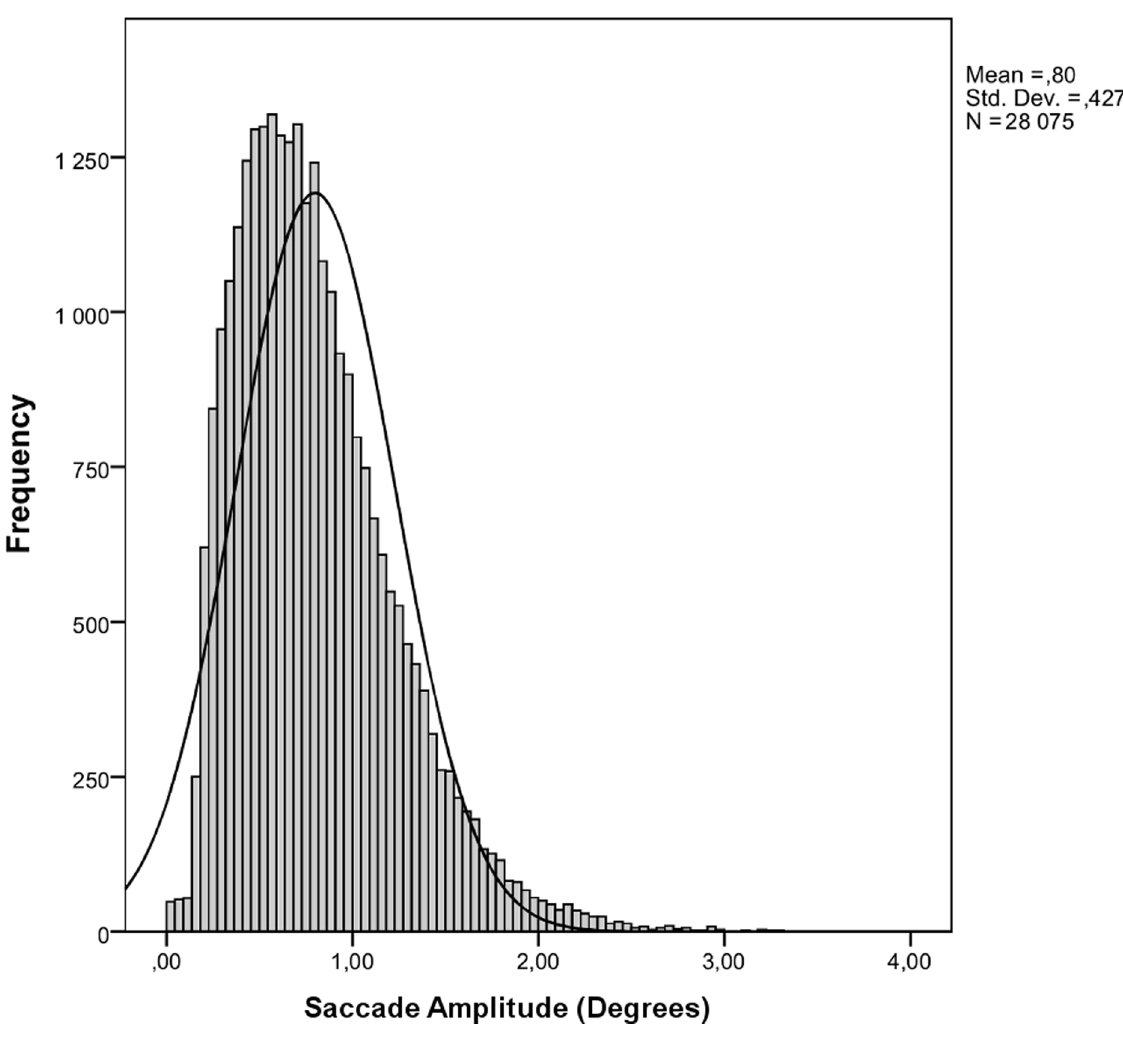
Figure 1. Distribution of saccade amplitudes.